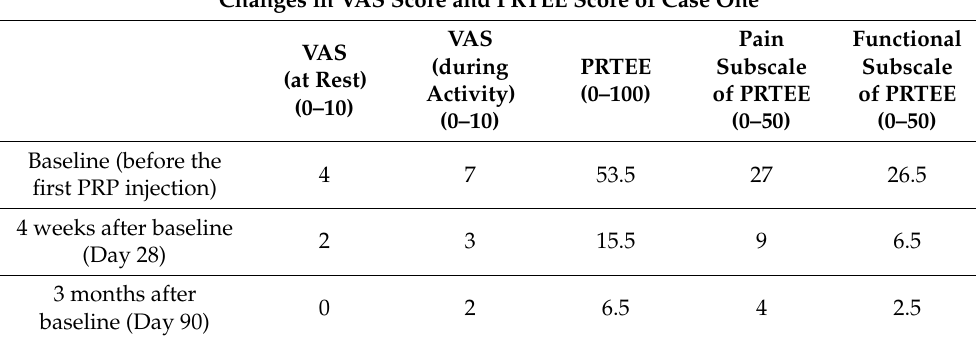
Table 1. Visual analogue scale (VAS) and patient-rated tennis elbow evaluation (PRTEE) scores of a patient with refractory lateral epicondylitis (case one) during baseline (before the first PRP injection) and four weeks or three months after baseline.